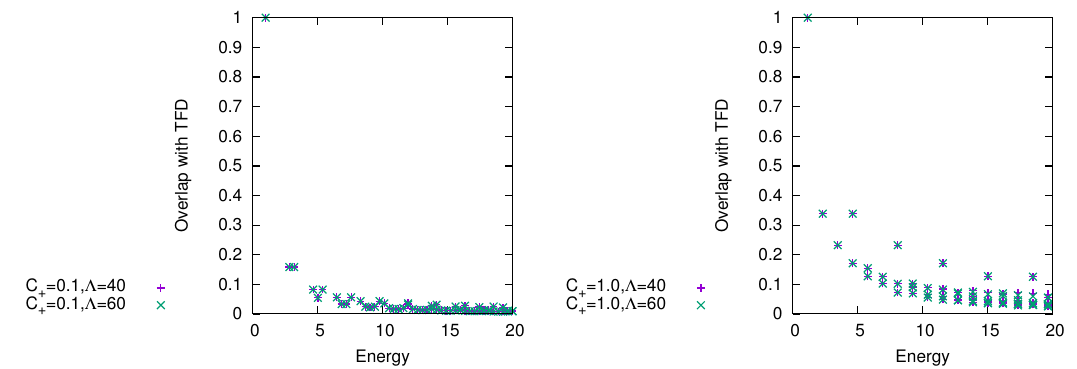
Figure 5 . |h TFD( β ) | n + , n − i coupled | 2 vs energy, for C + = 0 . 1 and C + = 1 . 0 , ω = 1 . At each energy, the value of β is chosen so that the overlap is maximized. Note that the overlap is exactly zero when n + or n − is odd (not shown in the